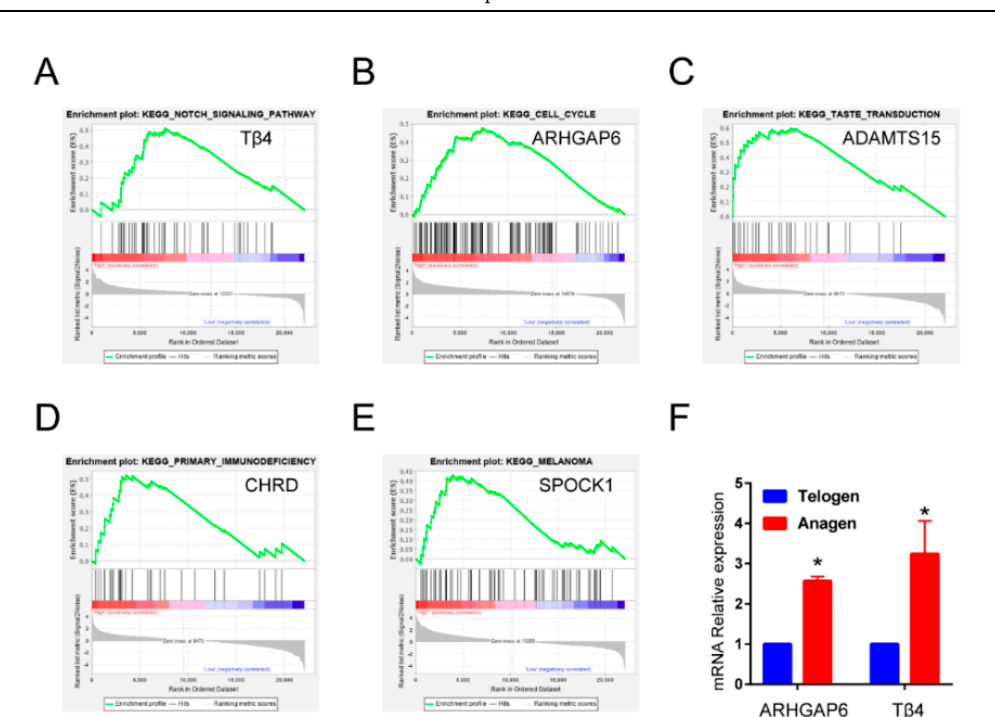
Figure 3. Screening of candidate genes from HF anagen to telogen stages of Albas cashmere goat. ( A–E ) Gene set enrichment analysis (GSEA) analysis of five candidate genes. ( F ) The two candidate genes most relevant to hair follicle growth were identified by quantitative real-time PCR (qPCR).